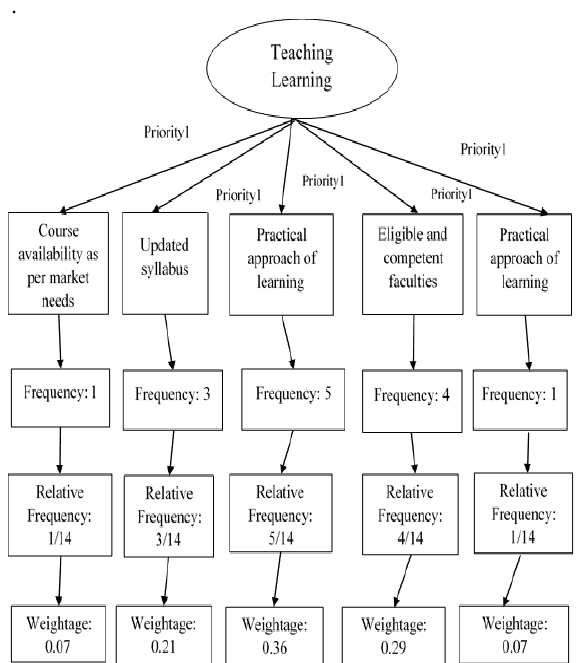
Figure 8. Weightage calculation of sub parameters